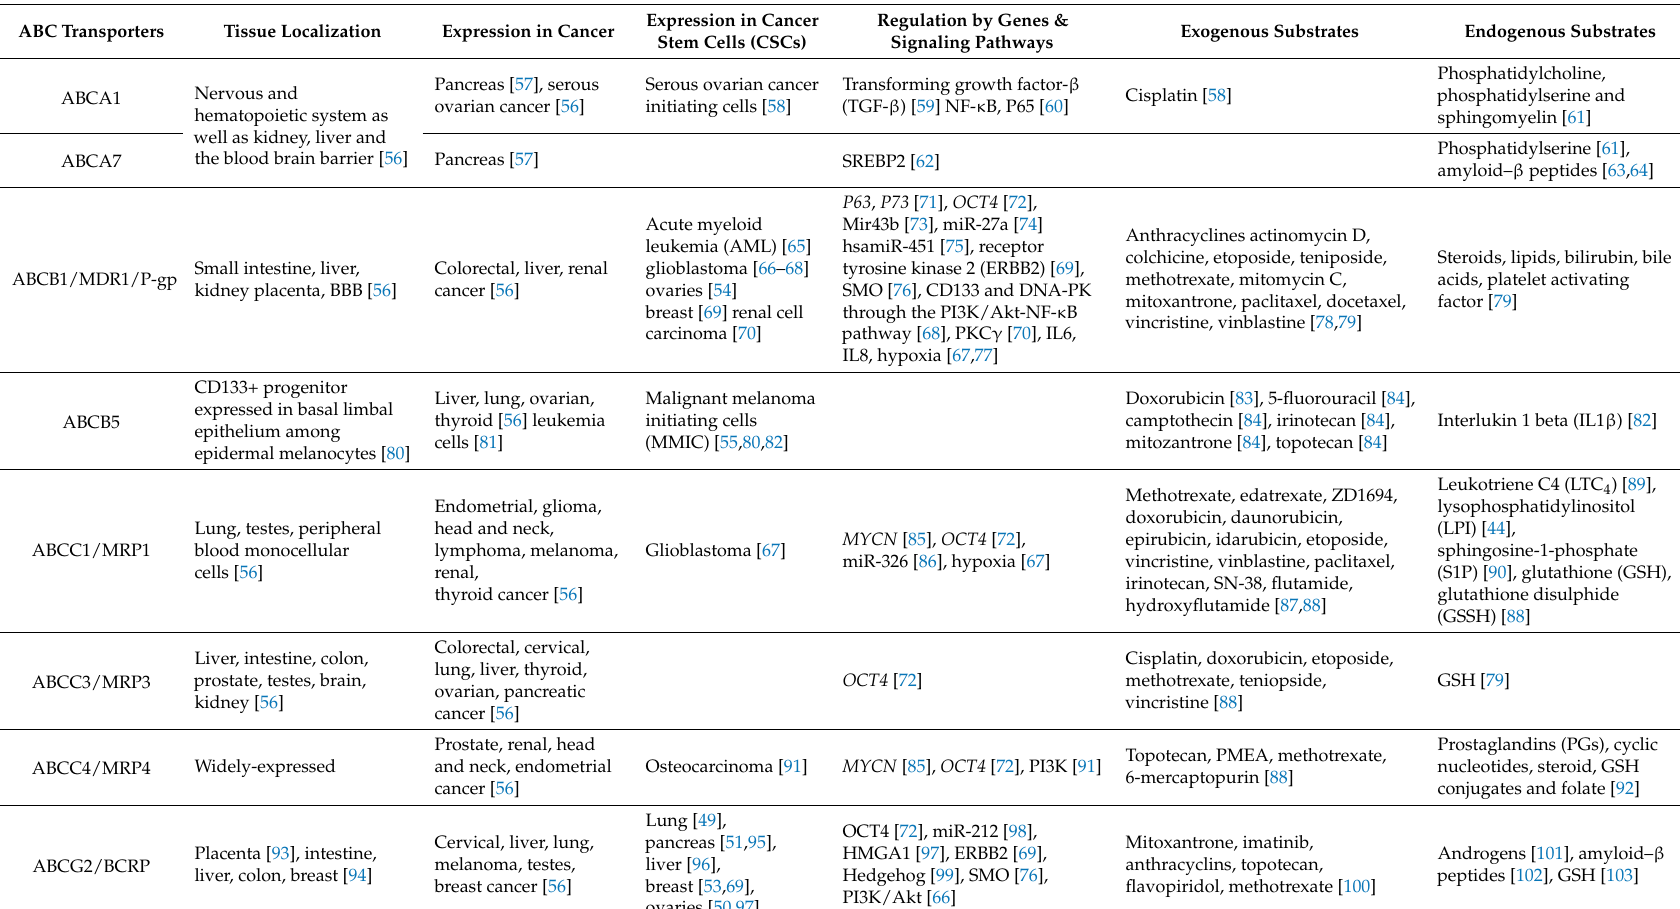
Table 1. ABC transporter location, regulation and